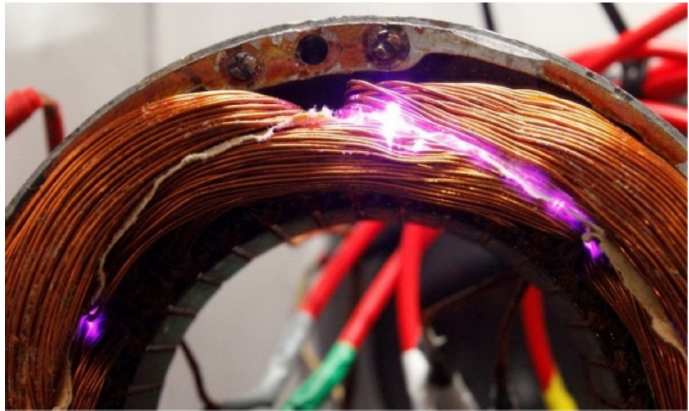
Figure 17. Corona effect in an electric motor winding [36].